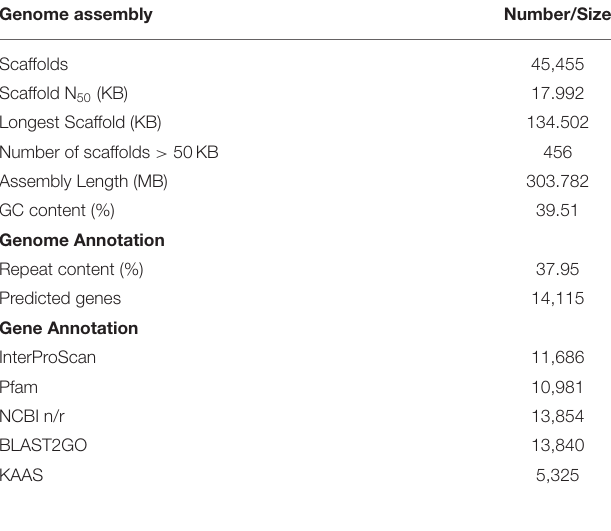
TABLE 2 | Allahabad Safeda draft genome assembly and annotation statistics.